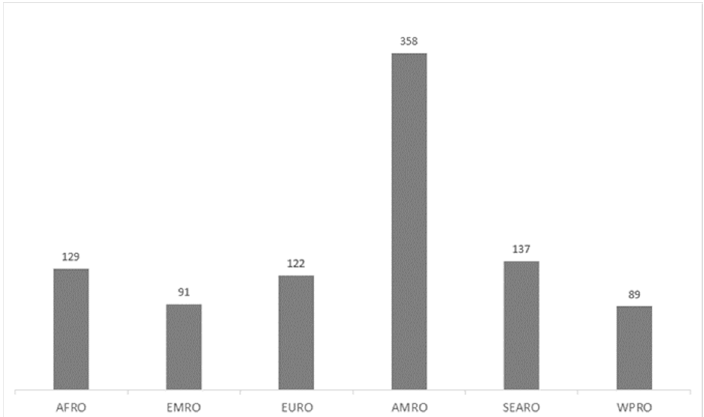
Figure 2. The 928 citations of the 78 lessons learned across WHO regions.